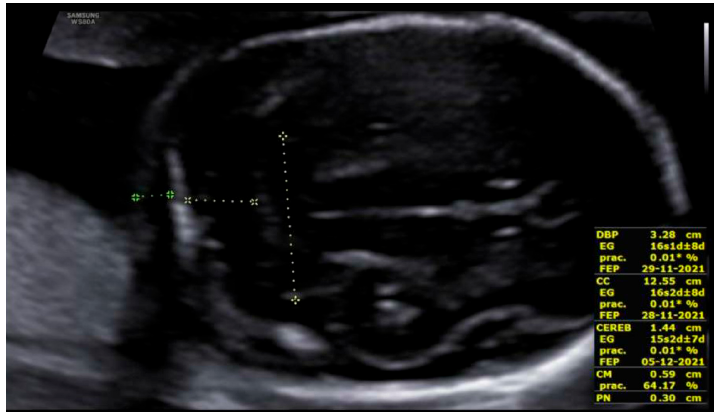
Figure 4. Axial view of the posterior fossa. Hypoplastic cerebellum: it shows cerebellum with a maximum transverse diameter of 14 mm. Cerebellomedullary cistern and nuchal fold within normal range.